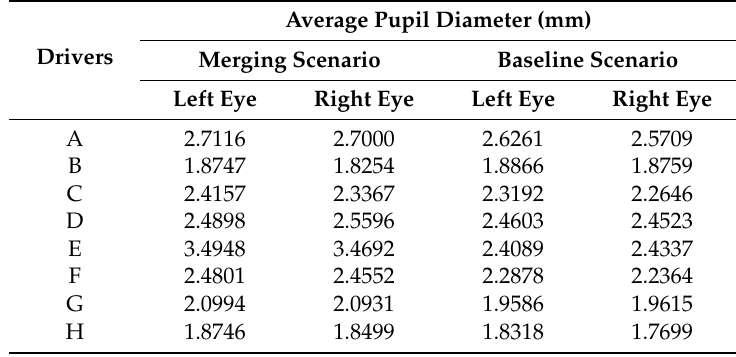
Table 6. Pupil average diameters in merge situations and